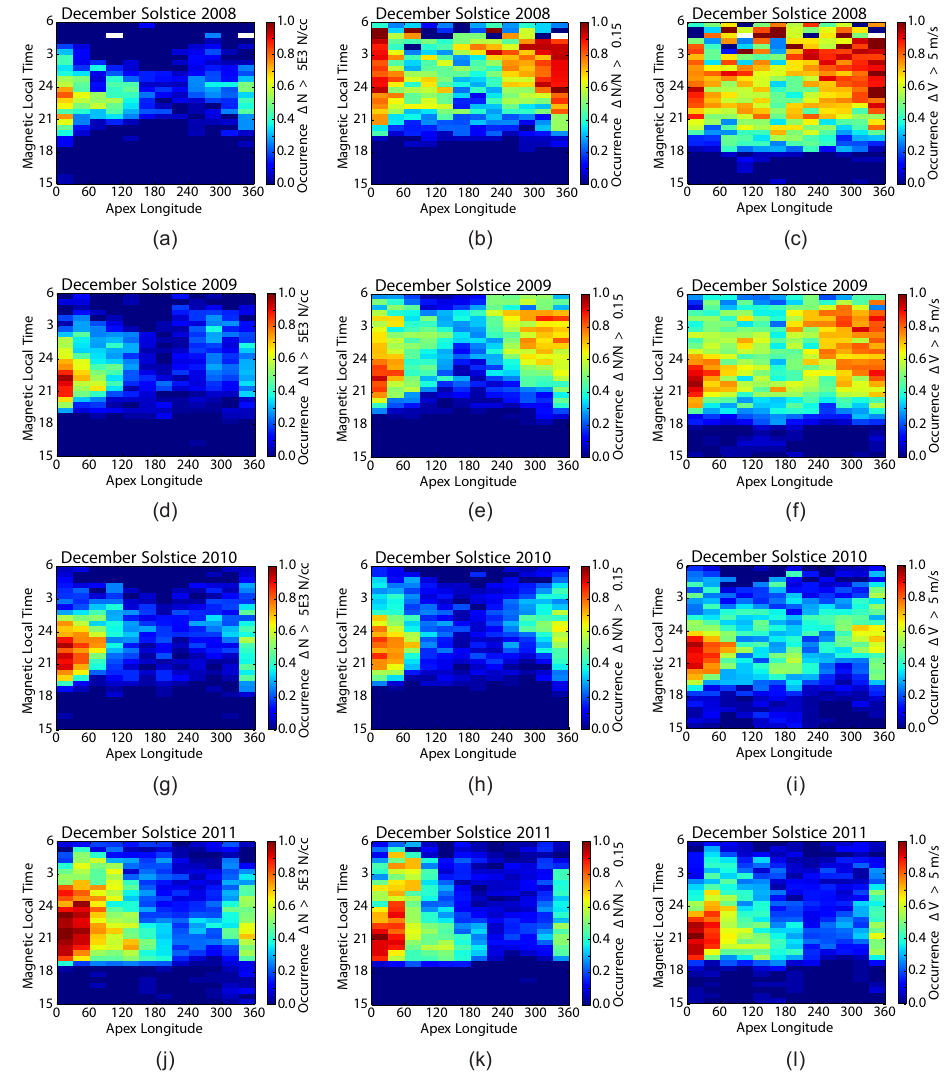
Fig. 3. Occurrence frequency of detecting ionospheric irregularities with CINDI over the December solstice seasons. Each column varies the wavelet product used, 1N (a – j) , 1N/N (b – k) , and 1V (c – l) . Each row increments the year, beginning with 2008 for (a – c) and ending with 2011 (j – l) . Measurements are restricted to altitudes below 550km with Kp less than 3+ for the previous 24h.